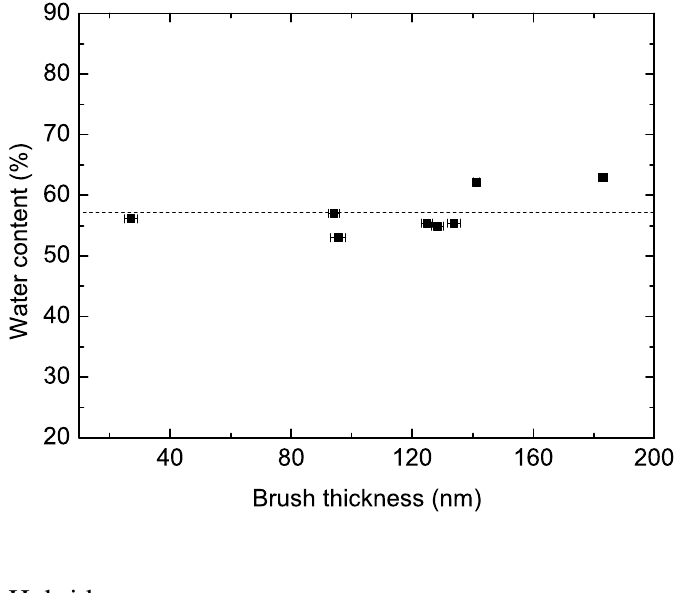
Figure 4. Water uptake of PDMAEMA brushes swollen in MilliQ water in dependence of brush